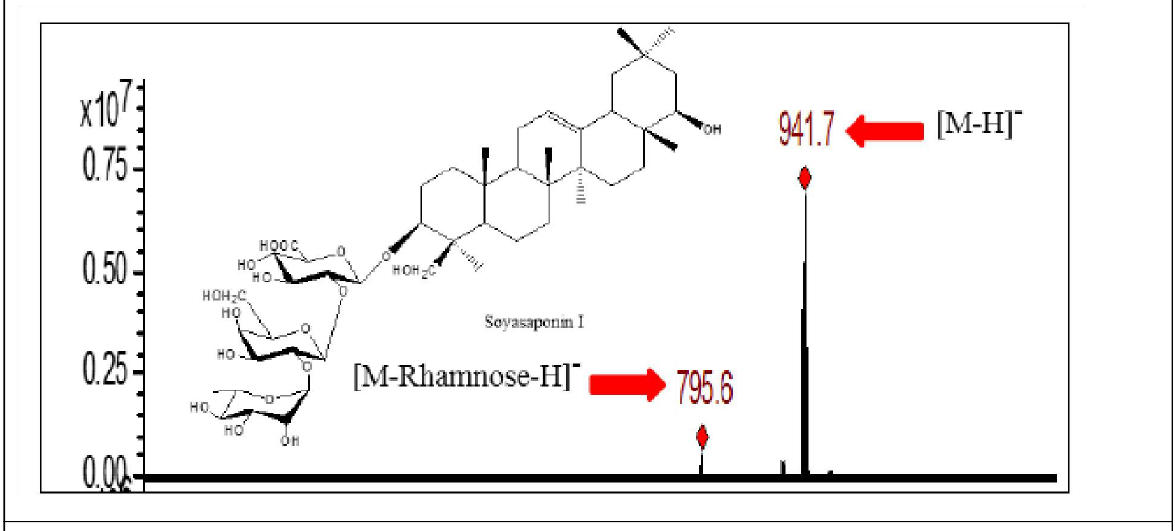
Figure 4: Negative ion mode ESI-MS spectrum of peak 1 in the n -butanol fraction of T. speciosa callus